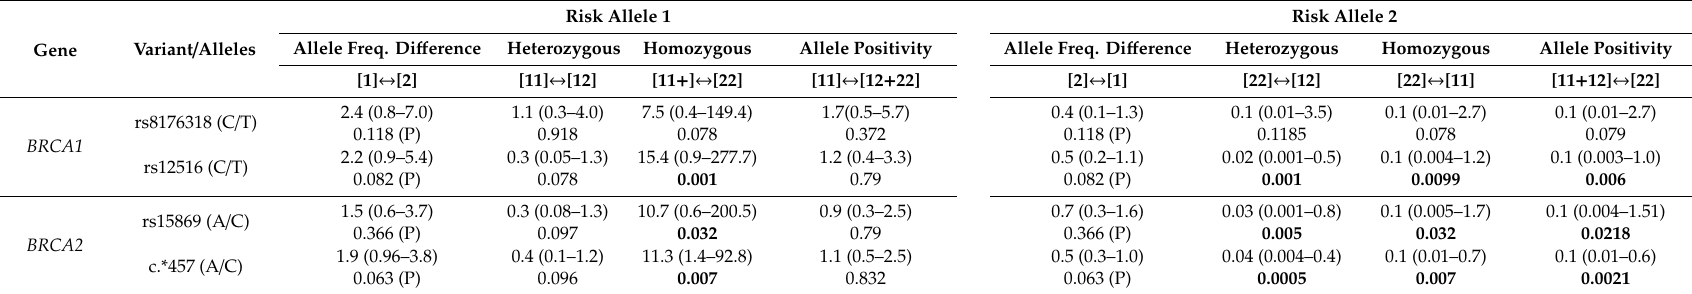
Table 4. Tests for association between genetic variants and hereditary breast and ovarian cancer. All tests were carried out with a 95% confidence interval (CI). Risk Allele Gene Variant / Alleles